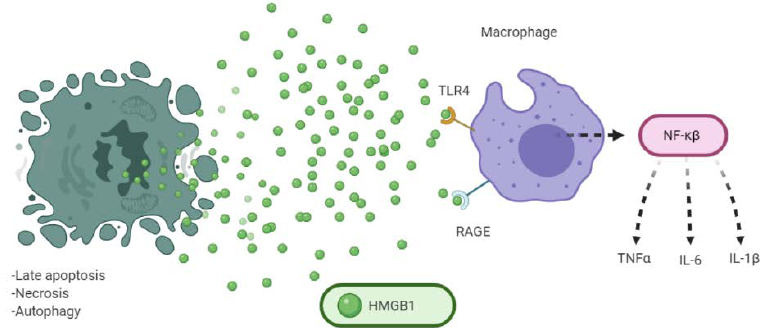
Figure 5. Implication of HMGB1 in cell death and activation of adaptative immune